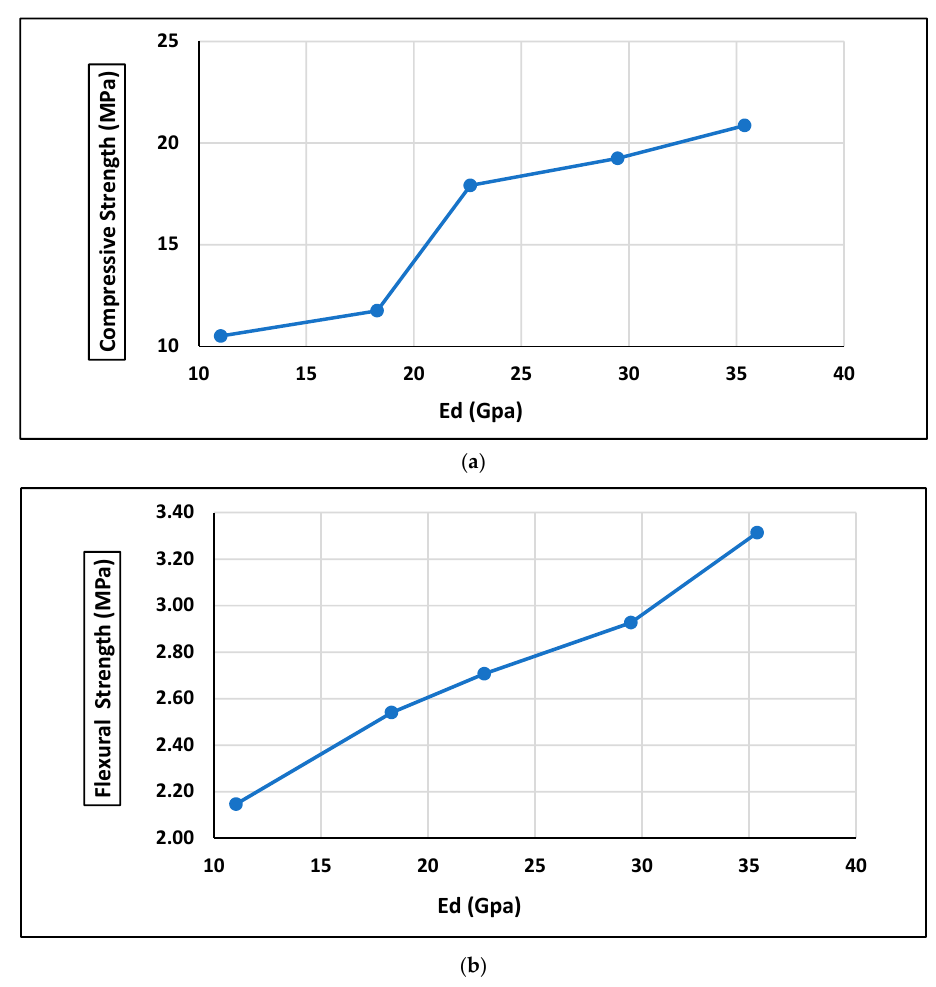
Figure 8. NDT–DT: dynamic modulus of elasticity (Ed) vs. ( a ) compressive strength and ( b ) flexural strength.